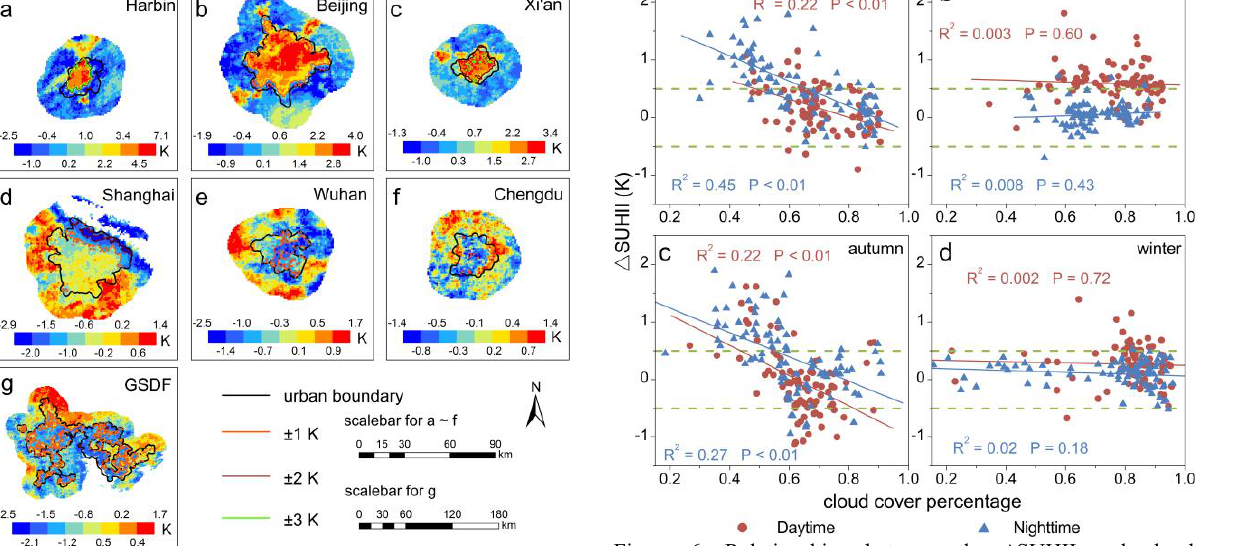
Figure 6. Relationships between the ∆SUHII and cloud percentage during the four seasons for both daytime and nighttime across the chosen 86 cities in Mainland